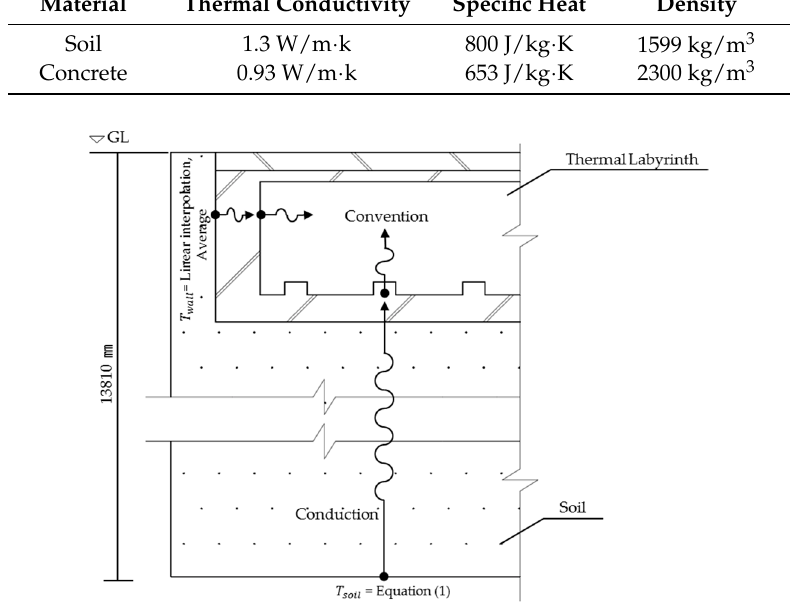
Figure 3. Heat transfer diagram.